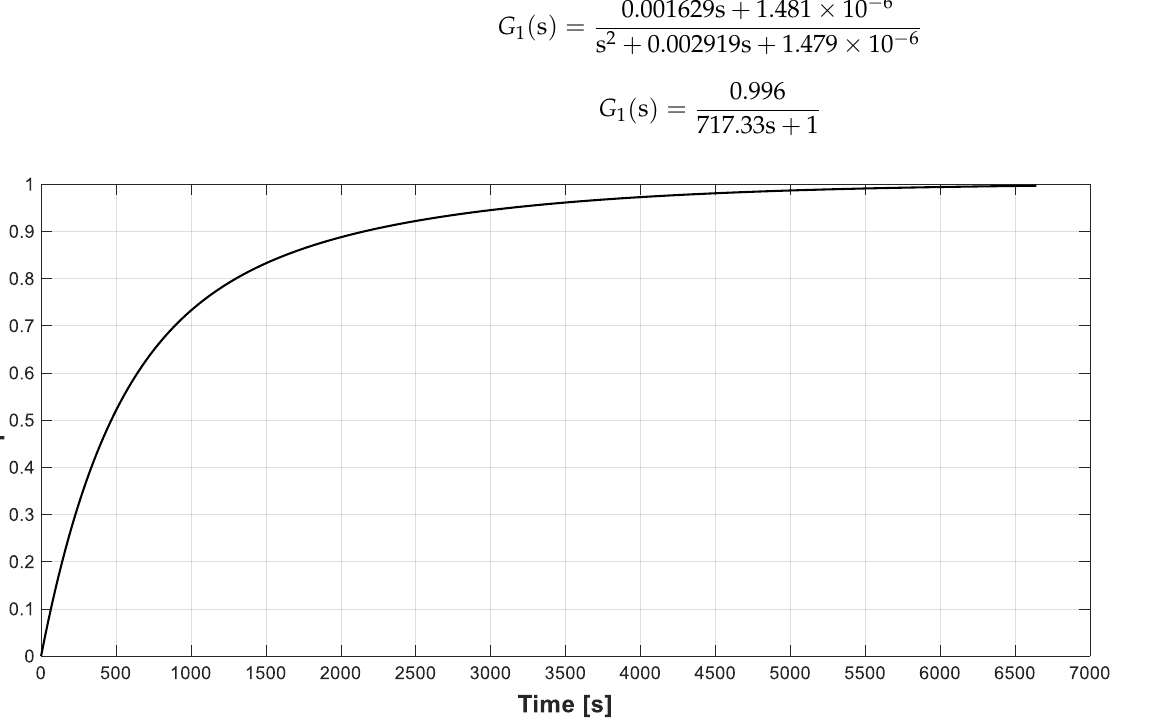
Figure 8. Comparison of the actual data with data simulated by the model.